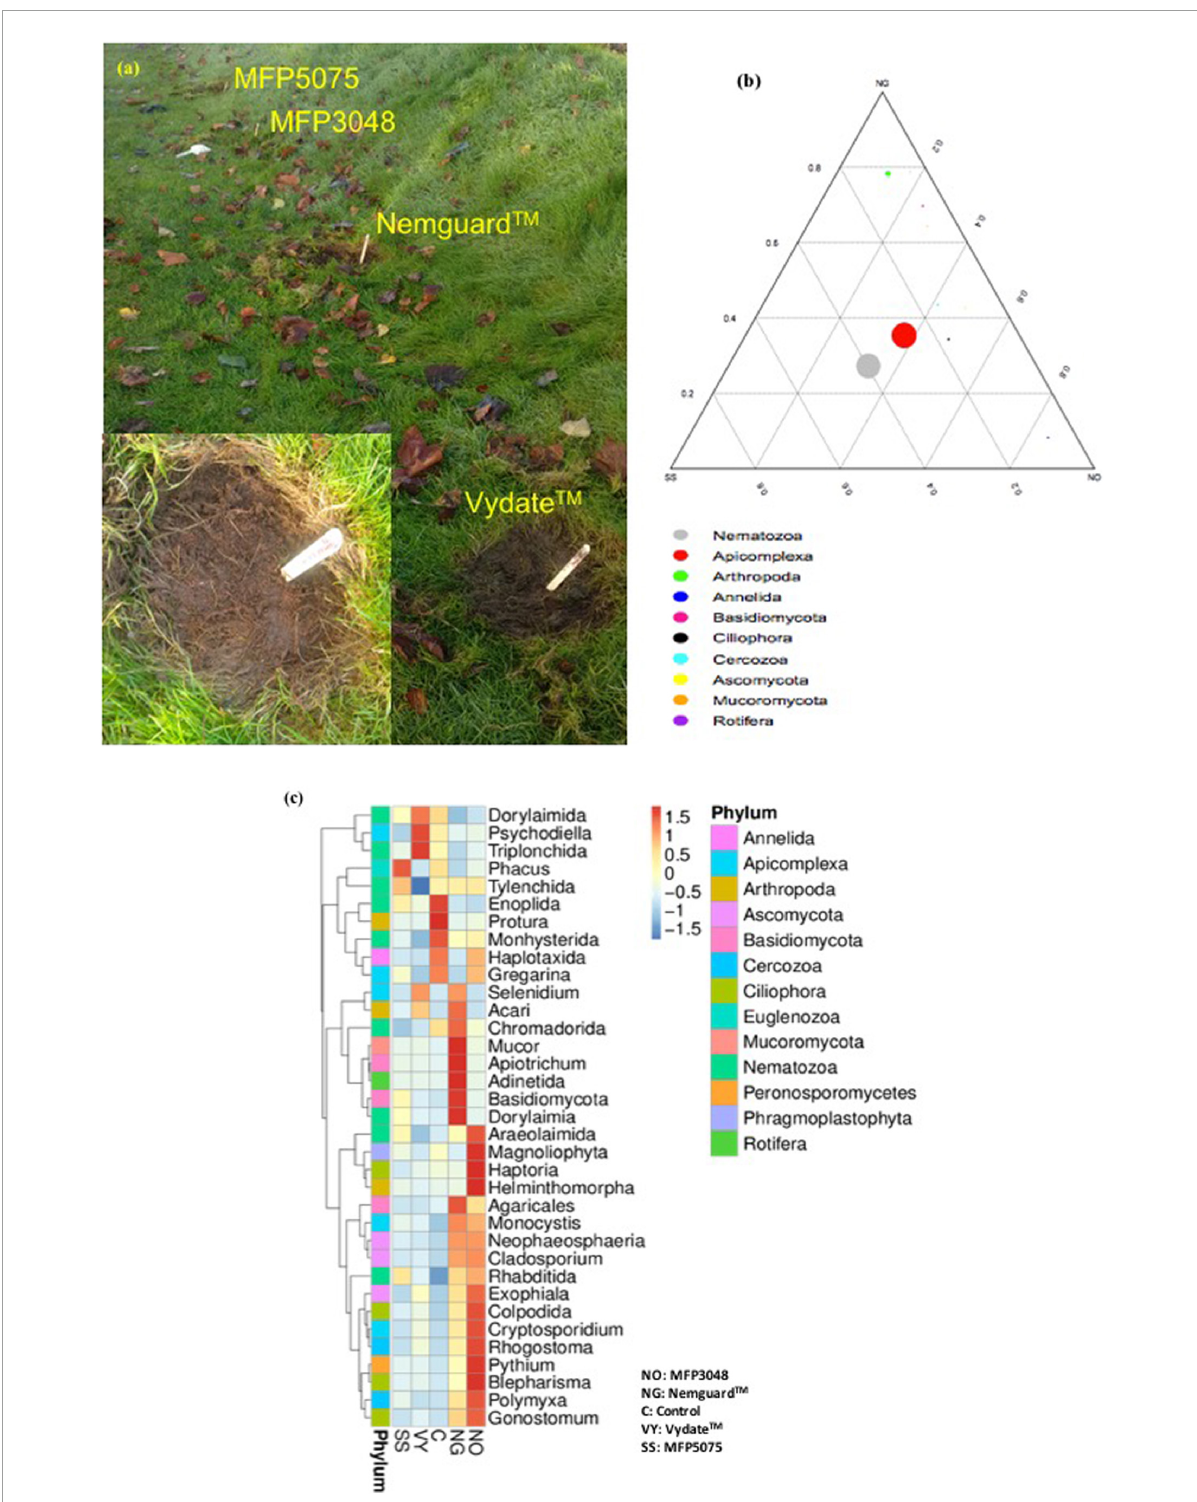
FIGURE1 (a) Garden patches showing treatments with different products; (b) Ternary plot; (c) Heatmaps representing the abundances of the top nine nematode orders in treatment groups. The Z-score ranges between 1.5 and –1.5 and represents the distance between the raw score and the mean of the standard deviation. “Z” is negative when the raw score is below the mean, and vice